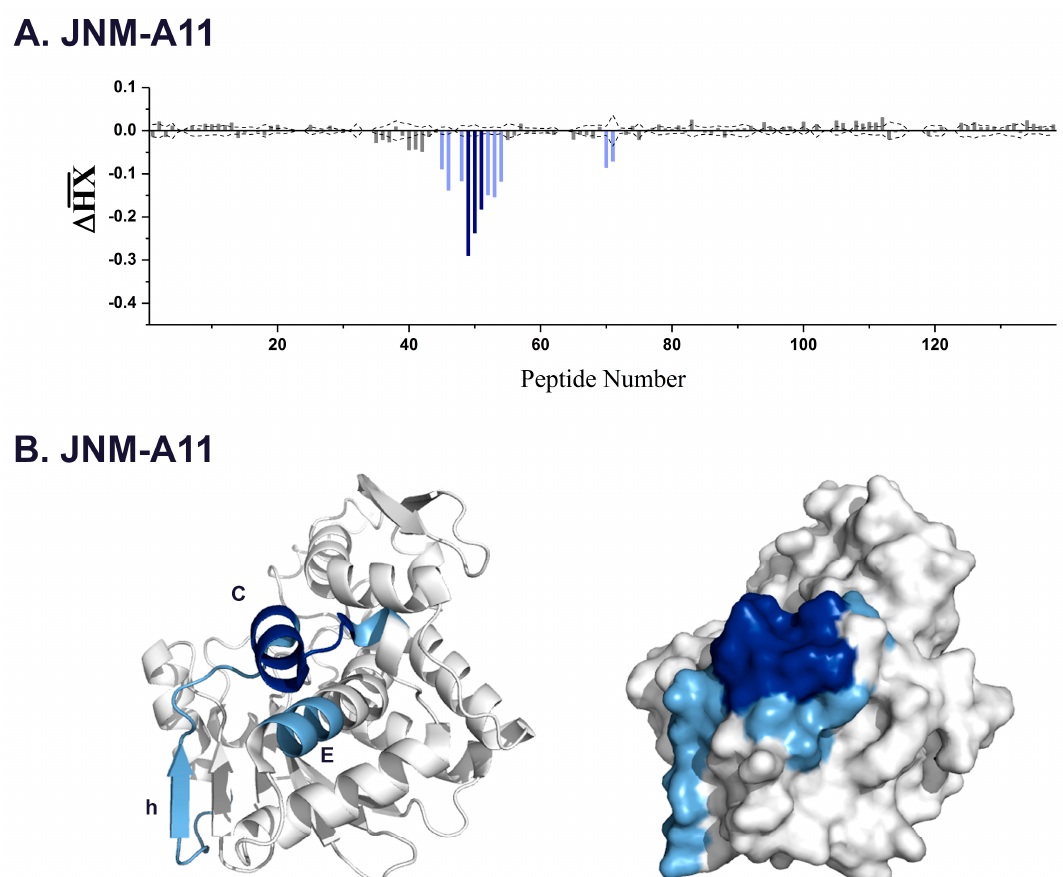
Figure 9. Epitope mapping of JNM-A11 from cluster 3.4. ( A ) Relative levels of protection of RiVax peptides by JNM-A11, as defined by HX-MS. The color shading corresponds to strong (deep blue), intermediate (light blue) or no significant protection (gray), as represented in Figure 4. ( B ) The HX protection categories, as shown in panel a, are mapped onto the crystal structure of RiVax. Secondary structures α -helices C and E and β -strand h are labeled.